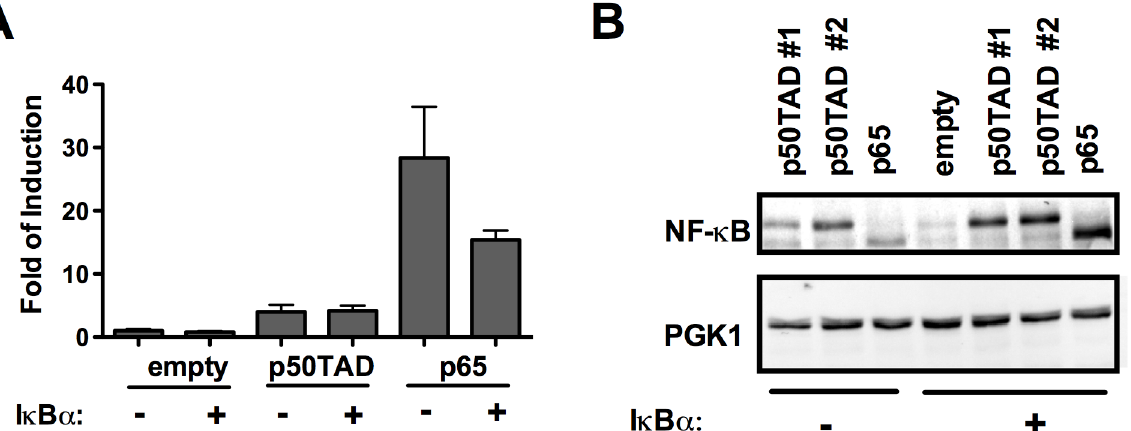
Fig 5. I κ B α inhibits p65-dependent transactivation in yeast. The highly responsive M2 strain was used to test the impact of co-expressing I κ B α with the NF- κ B proteins p50TAD or p65. A) Luciferase assays results were obtained and plotted as described in Fig 1. Control transformants lacking the I κ B α expression construct were obtained using the pRS315 empty vector. Cells were cultured in 0.032% galactose for 16 hours to achieve moderate expression of p50TAD or p65. I κ B α is expressed under the constitutive ADH1 promoter. For all conditions the light units were normalize for the optical density of the cultures. The relative luciferase activity, obtained with cells transformed with empty vectors was set to 1 and used to obtained the fold of reporter induction due to the expression of NF- κ B proteins. Bars plot the average and standard errors of four biological replicates. B) A western blot image revealing the impact of I κ B α on p50TAD or p65 protein levels. Transformants with two p50TAD expression vectors that differ for the selection marker gene (LEU2 for p50TAD #1 and TRP1 for p50TAD #2) were included. PGK1 was used as loading control.